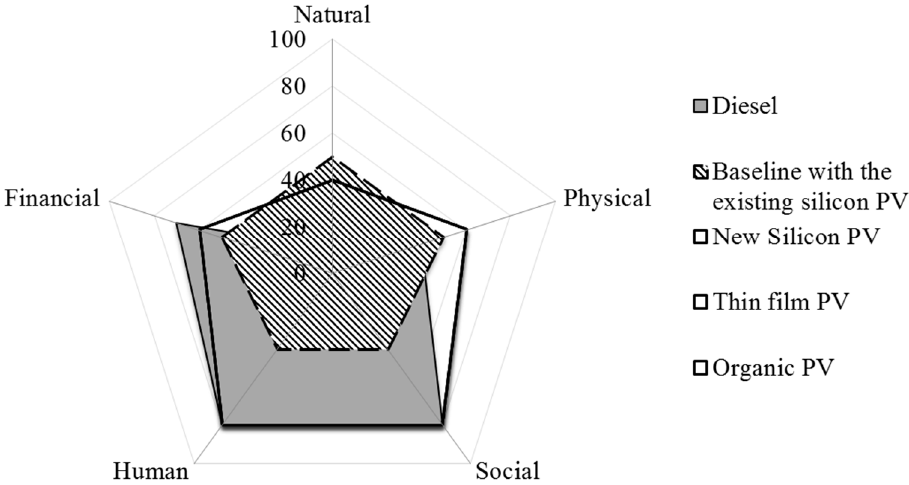
Figure 1. Local impact of solar energy technologies, and diesel on livelihoods capital, Las Calabazas, Cuba, 2012.